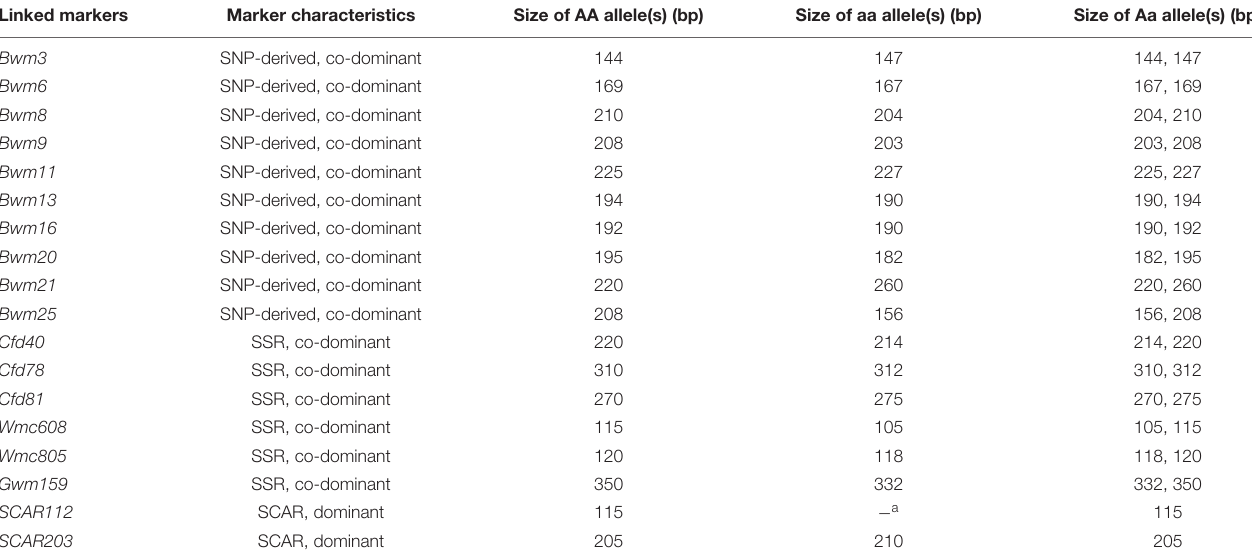
TABLE 2 | Characteristics and sizes of the homozygous allele of the FG-1 (AA), homozygous allele of the Mingxian 169 (aa) and heterozygous allele (Aa) of the PmFG -linked markers from the reactions of F 2 : 3 families of FG-1 and Mingxian 169. Linked markers Marker characteristics